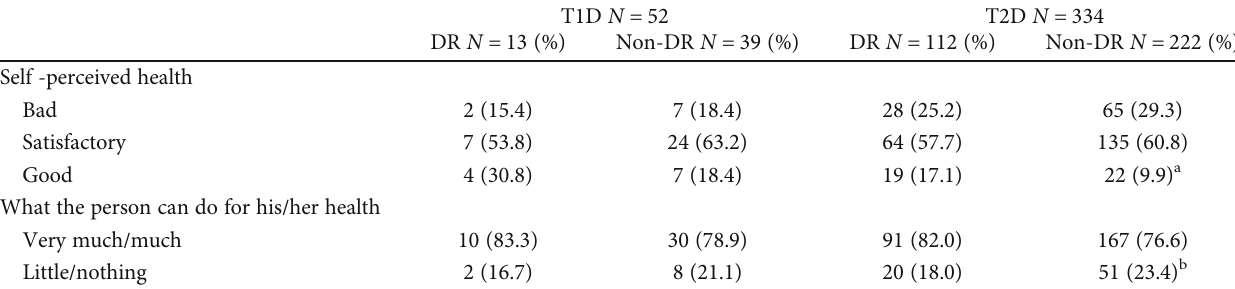
Table 2: Self-perceived health status of the study sample.